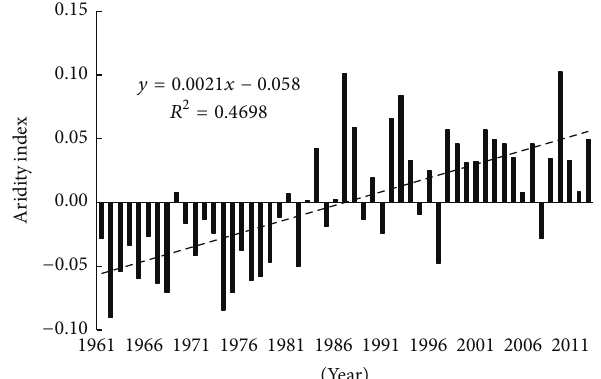
Figure 3: Change in the AI anomaly in North Xinjiang, China, during